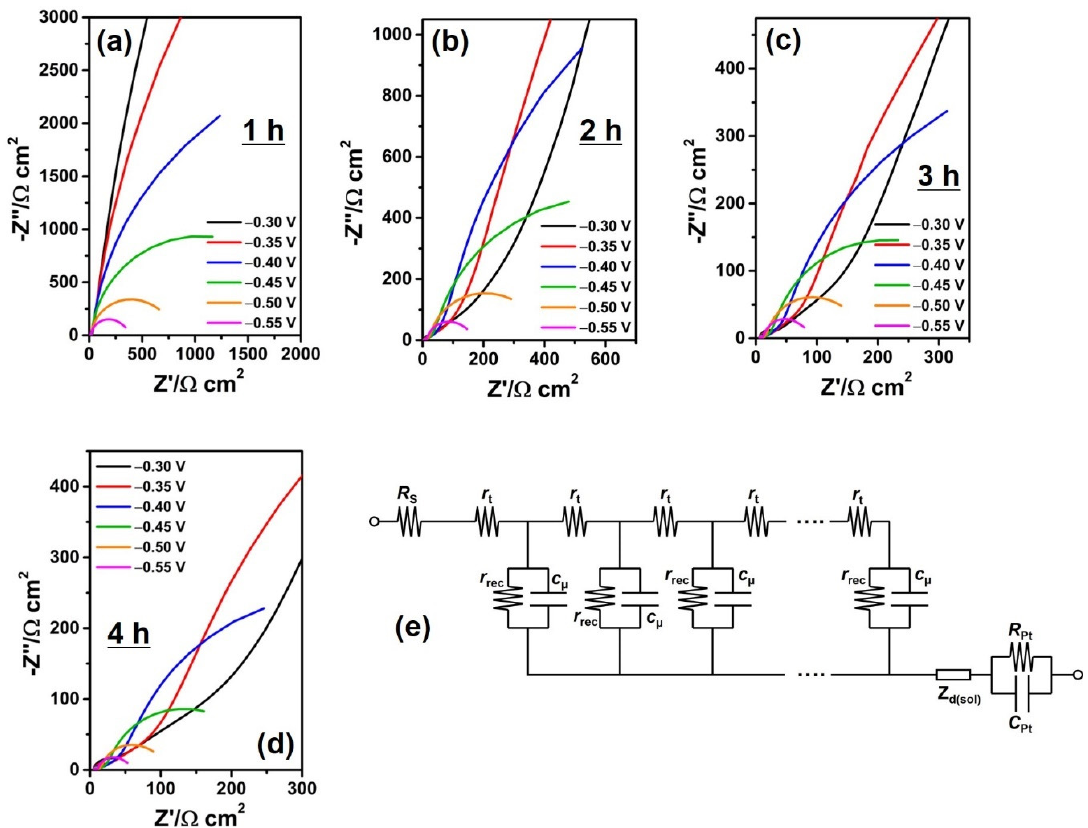
Figure 5. ( a – d ) Impedance spectra obtained at bias potentials of − 0.30 to − 0.55 V for the quasi-solid-state DSSCs based on the anodic TiO 2 NT electrodes depending on the anodization time, and ( e ) the equivalent circuit model for the analysis of impedance spectra.